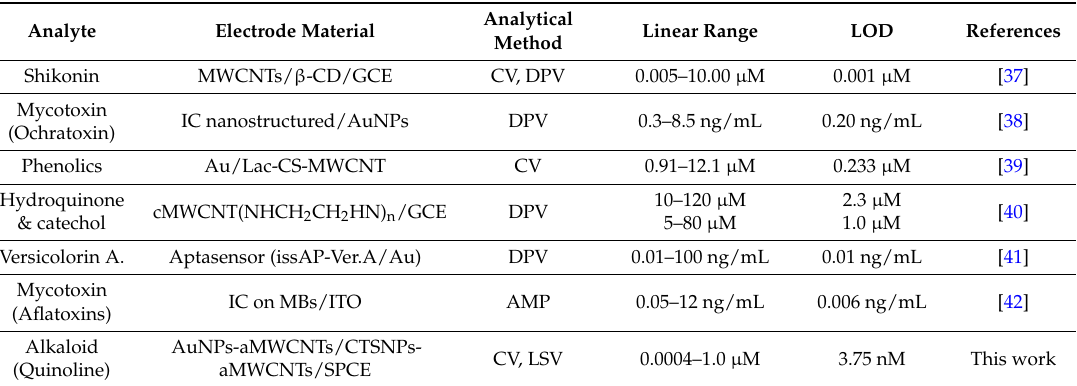
Table 2. Comparison of this work with previous